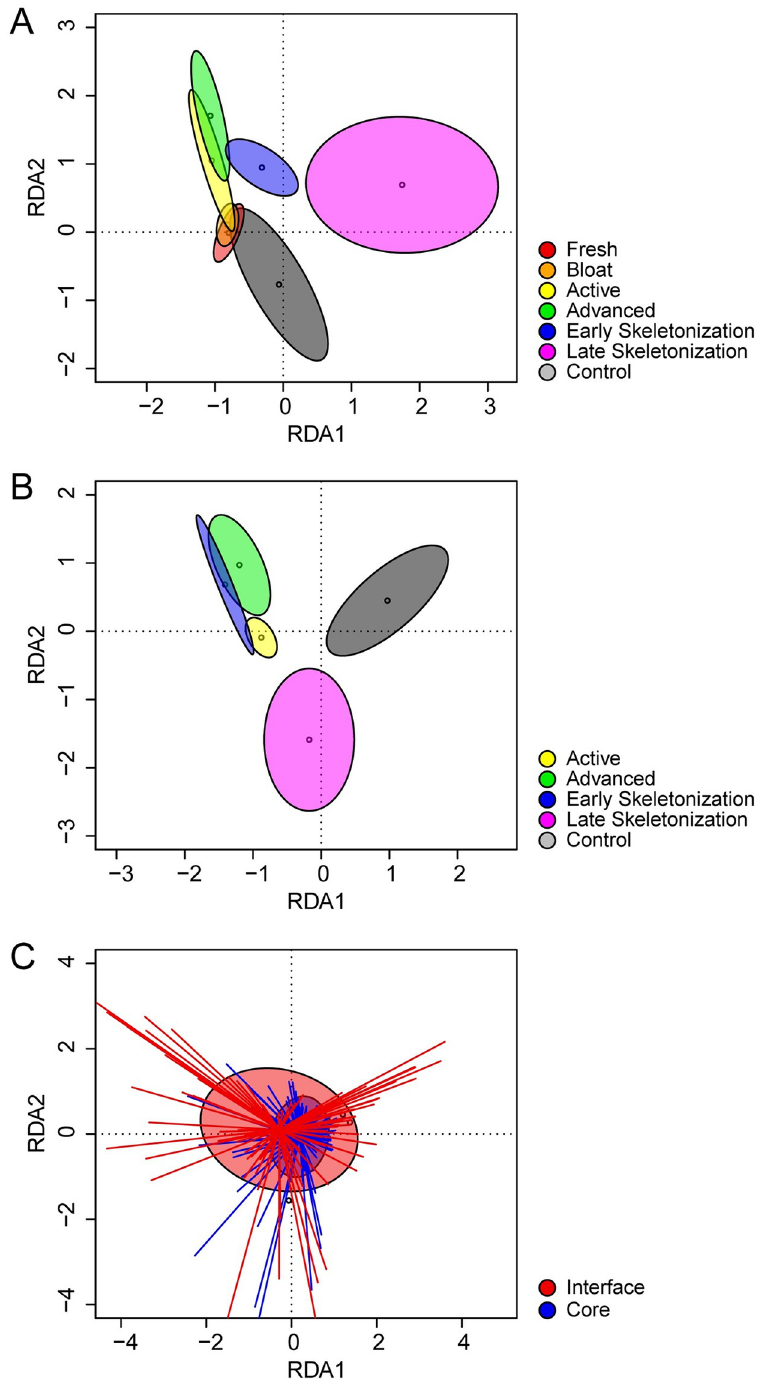
Fig 4. Nematode beta diversity. RDA biplots of nematode community trajectory during decomposition progression in (A) core (0–30 cm) and (B) interface (0–1 cm) soils. Ellipses represent standard deviations from decay stage centroids. Samples are grouped by morphological decomposition stage. Comparative changes at both soil depths (C) are shown for the entire study. Ellipses represent standard deviations from depth centroids, and spiders show distances from